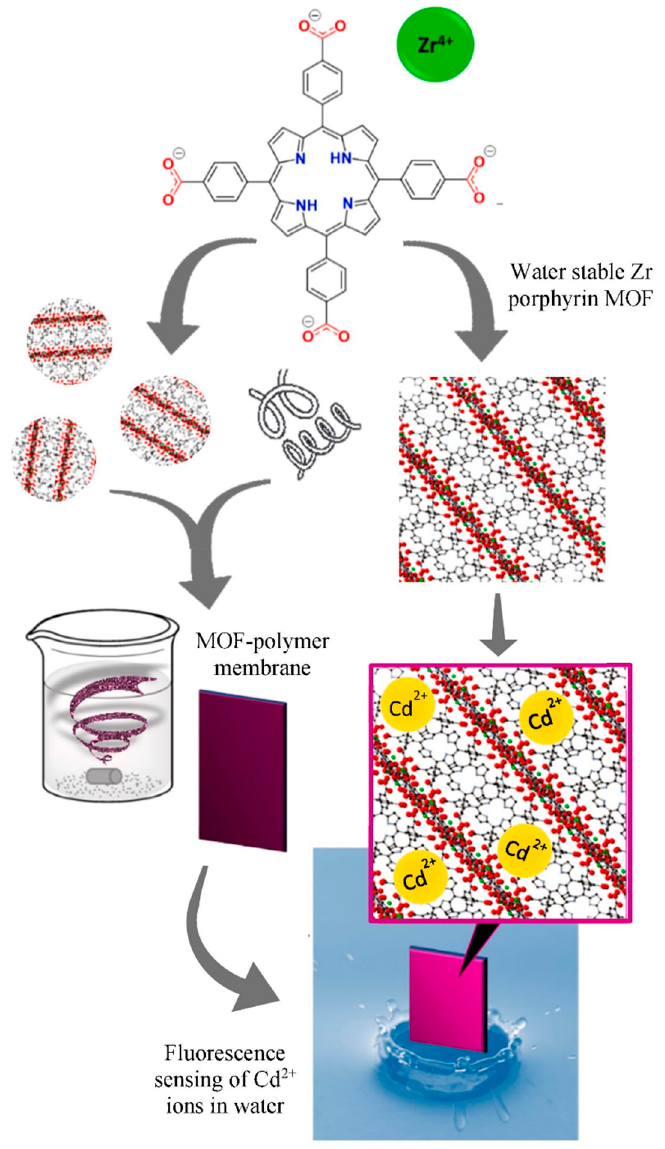
Figure 16. Schematic diagram of the detection for cadmium ions with MOF powder and polyvinyl chloride (PVC) membrane composites in aqueous solution. Reprinted with permission from ref [55].